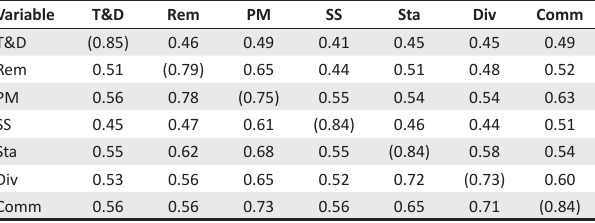
TABLE 5: Factor and scale correlations of the Human Resource Practices Scale.